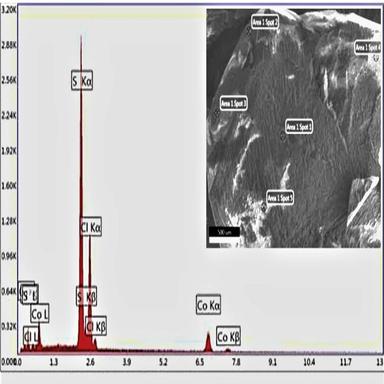
Spectrum and scanning electron microscopy spots of tetrakis(thiourea)cobalt chloride single crystal.